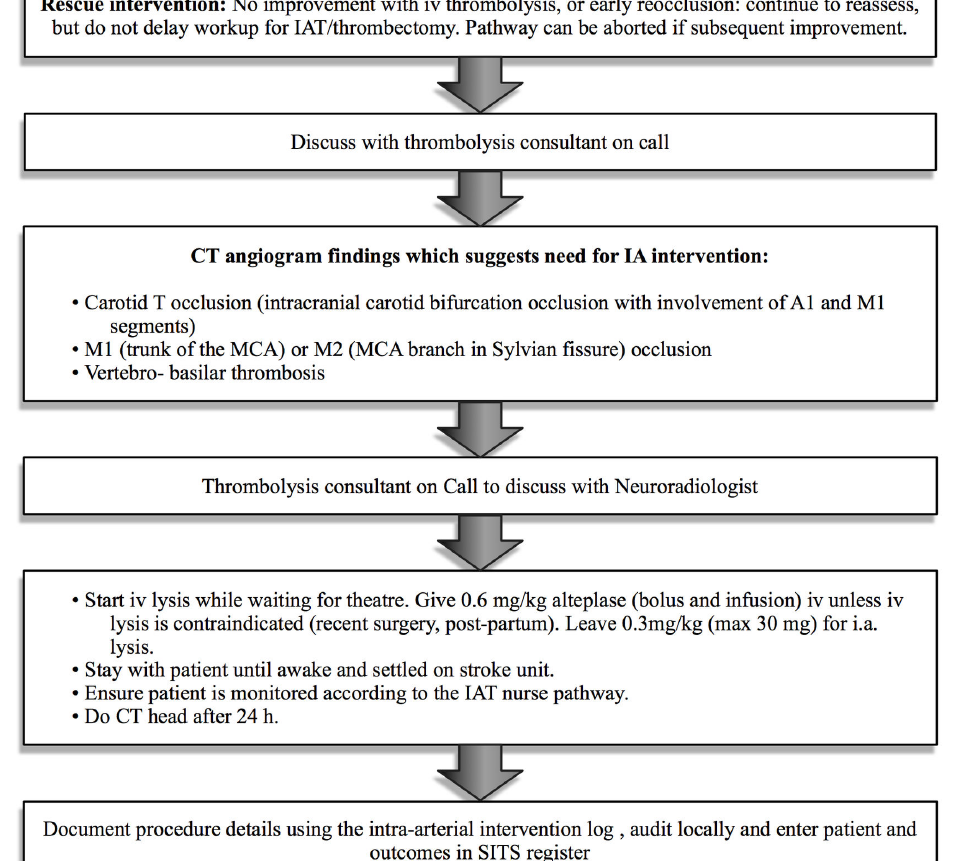
Figure 1. Pathway for endovascular treatment. Treatment pathway used in this study for intra-arterial thrombolysis and/or thrombectomy. doi: 10.1371/journal.pone.0082218.g001 PLOS ONE |